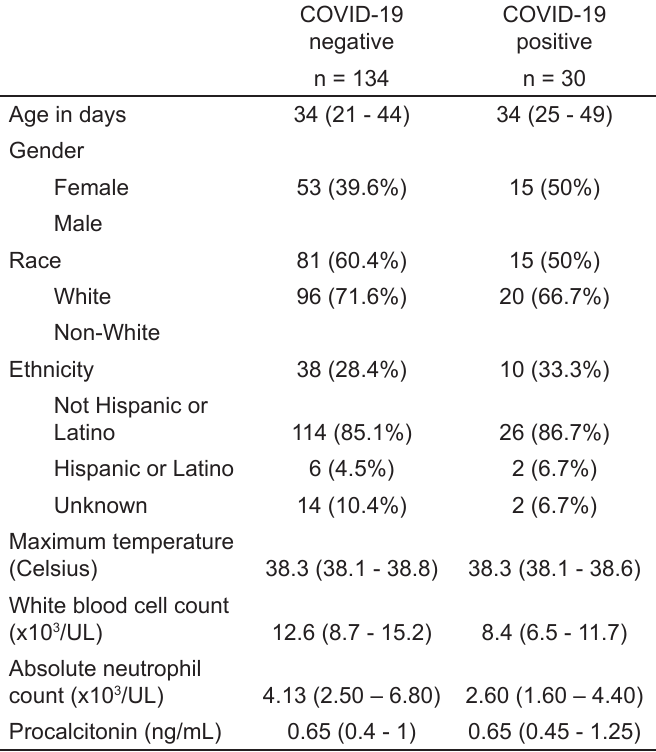
Table 1. Summary of study participants’ characteristics by